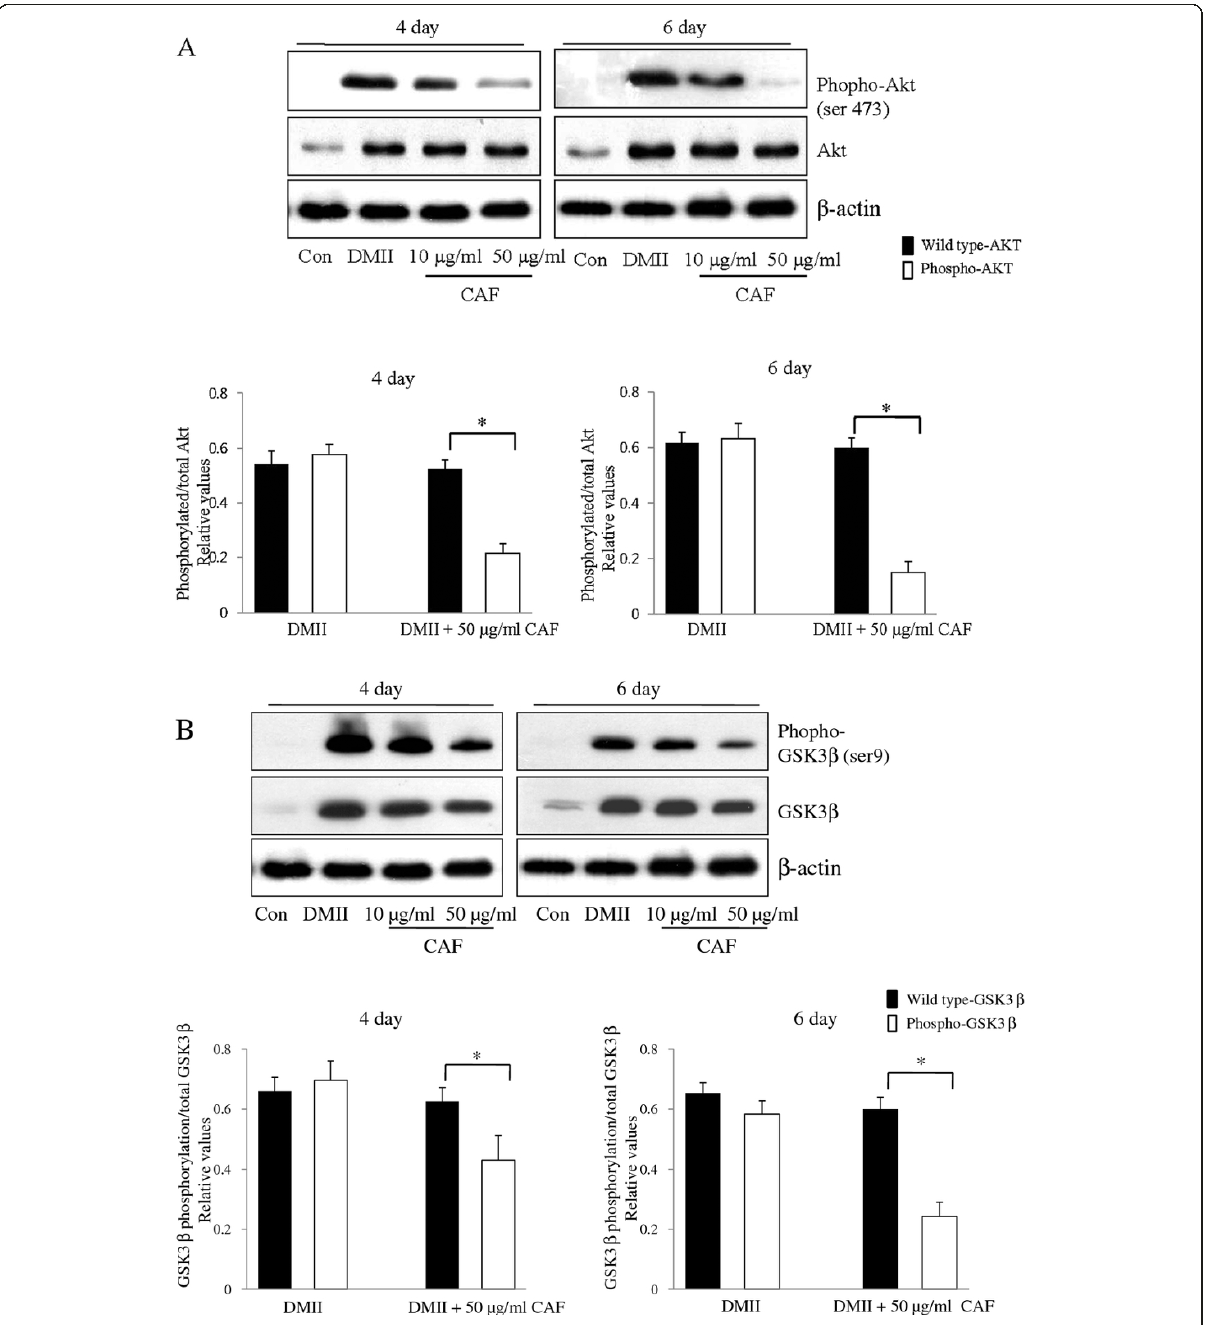
Figure 3 Effect of CAF on phosophorylation of Akt and GSK3 b during 3T3-L1 differentiation . 3T3-L1 preadipocytes were differentiated in the absence or in the presence of CAF for 6 days. (A) Immunoblotting analysis for wild type Akt and pAkt (Ser 473) was described under Materials and Methods. These experiments were conducted as independent experiments in triplicate. Data represent the mean ± SD. (*) p < 0.05. (B) Immunoblotting analysis for wild type GSK3 b and pGSK3 b (Ser-9) was described under Materials and Methods. These experiments were performed as independent experiments in triplicate. Data represent the mean ± SD. (*) p < accumulation. Our results show that CAF treatment sig- CAF inhibited the differentiation of 3T3-L1 preadipo- nificantly down-regulated PPAR g and C/EBP b at the cytes into adipocytes and also inhibited the accumula- mRNA and protein levels, compared to those in fully tion of lipid droplets in the cytoplasm, an adipocyte differentiated adipocytes. PPAR g and C/EBP b , which are phenotype that follows differentiation based on lipid